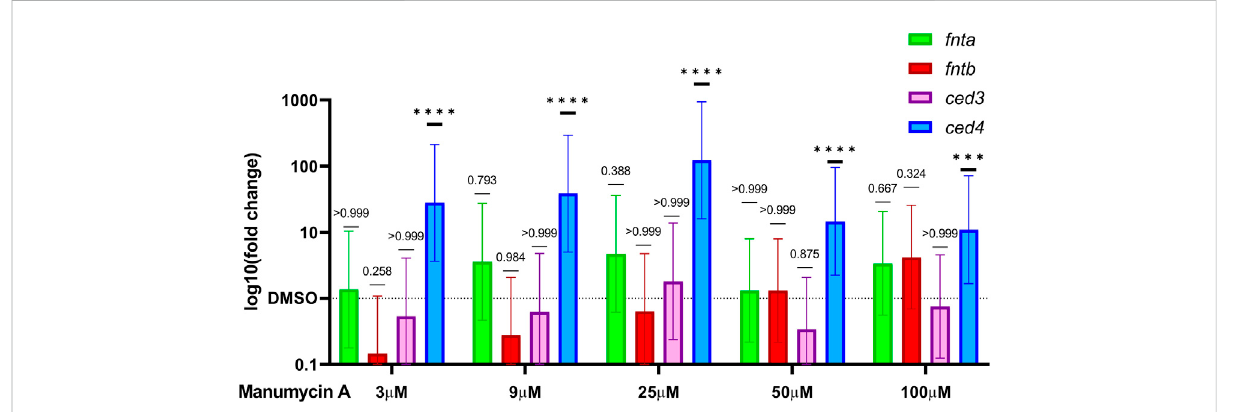
Change in the relative expression of FTase and apoptosis related genes. Relative expression of fnta and fntb and ced-3 and ced-4 after treatmentwith3 μ Mor100 μ MofManumycinA.Graphsrepresentthelog10relativefoldchanges(10 − ΔΔ Cq )normalizedtoarespectiveDMSOcontrol group. Cq values were corrected for ampli fi cation ef fi ciency following the formula CqE = log10 (E p )*Cq. ΔΔ CqE was calculated by means of ANOVA and Tukey ’ s multiple comparisons test. Mean differences and 95% CI were transformed back (10 - ΔΔ CqE ) to obtain the relative fold change. * p < 0.05, ** p < 0.01, *** p <